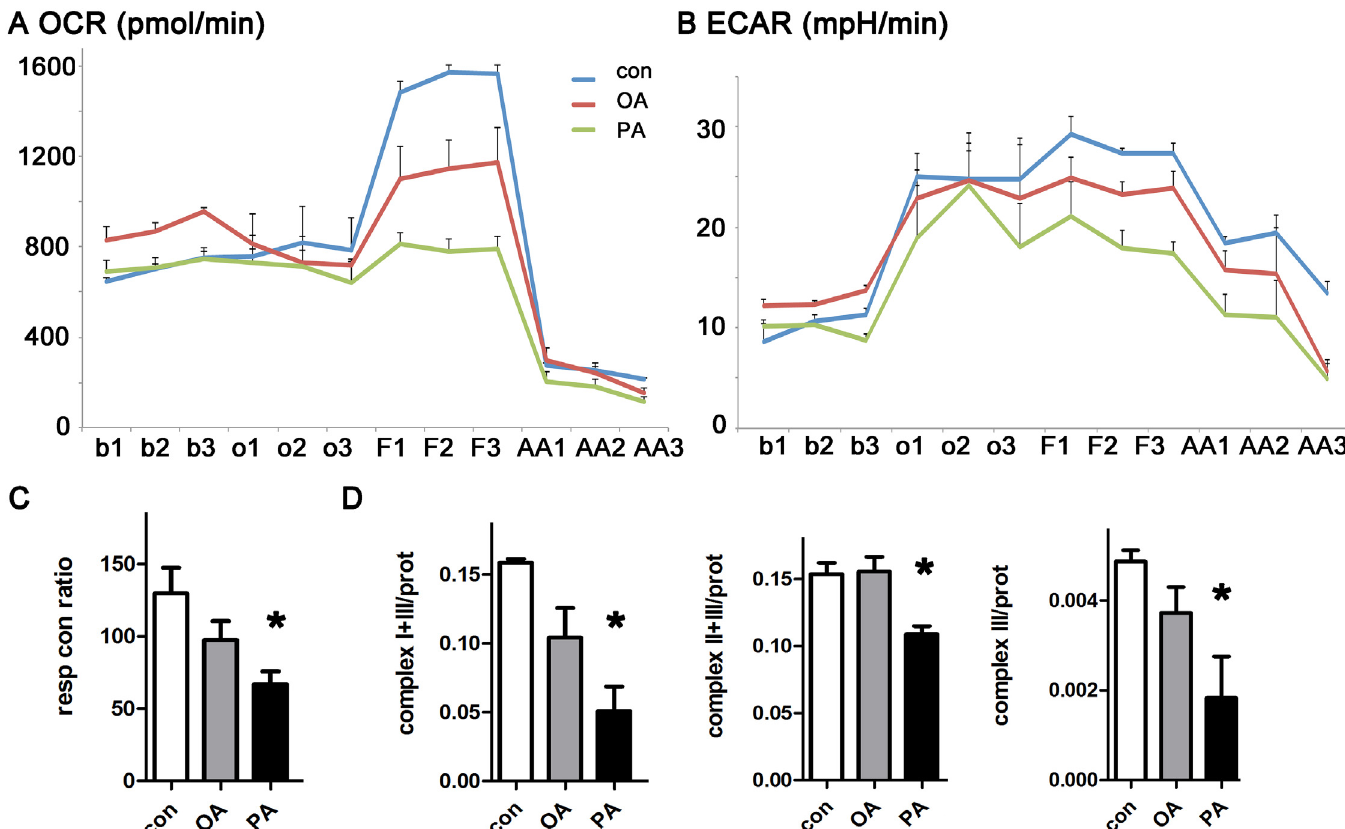
Fig 1. Palmitate causes a decrease in mitochondrial oxygen consumption in cardiomyocytes. A. Oxygen consumption rate is decreased by palmitate. B. Extracellular acidification rate from the same experiment. Data from WT cardiomyocytes. Measurements from three time-points were obtained under each condition, using triplicate wells. b = baseline, o = oligomycin, F = FCCP, AA = antimycin-A and rotenone. C. Respiratory control ratio is reduced significantly by palmitate. D. Electron transport chain complex III activity is significantly reduced by palmitate. Units are nanomoles substrate utilized/min/mg protein. The means of all graphs are significantly different by ANOVA, * = sig different from control by post-hoc